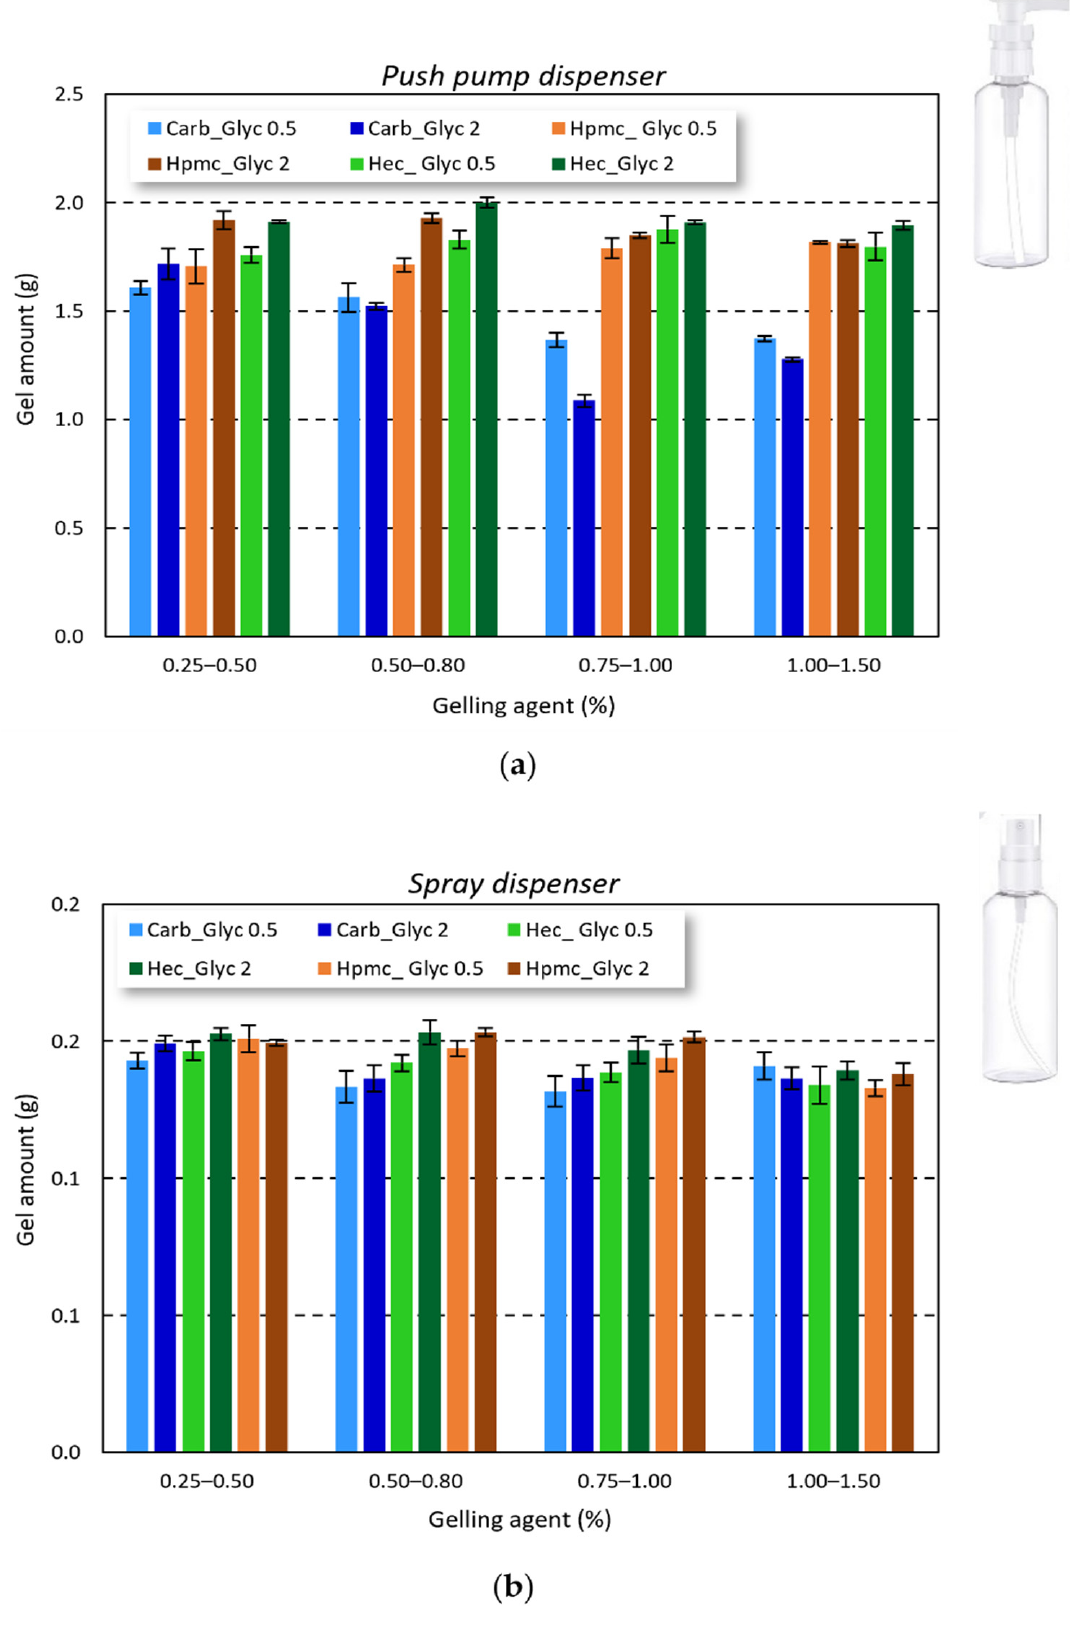
Figure 5. Gelamountdeliveredbythecommerciallyavailablebottles: ( a )pushpumpand( b Figure 5. Gel amount delivered by the commercially available bottles: ( a ) push pump and ( b ) spray dispenser.